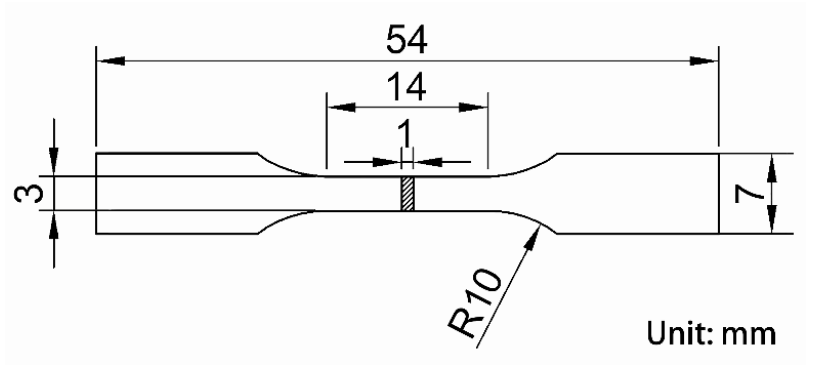
Figure 2. Geometric dimension of the tensile specimen.